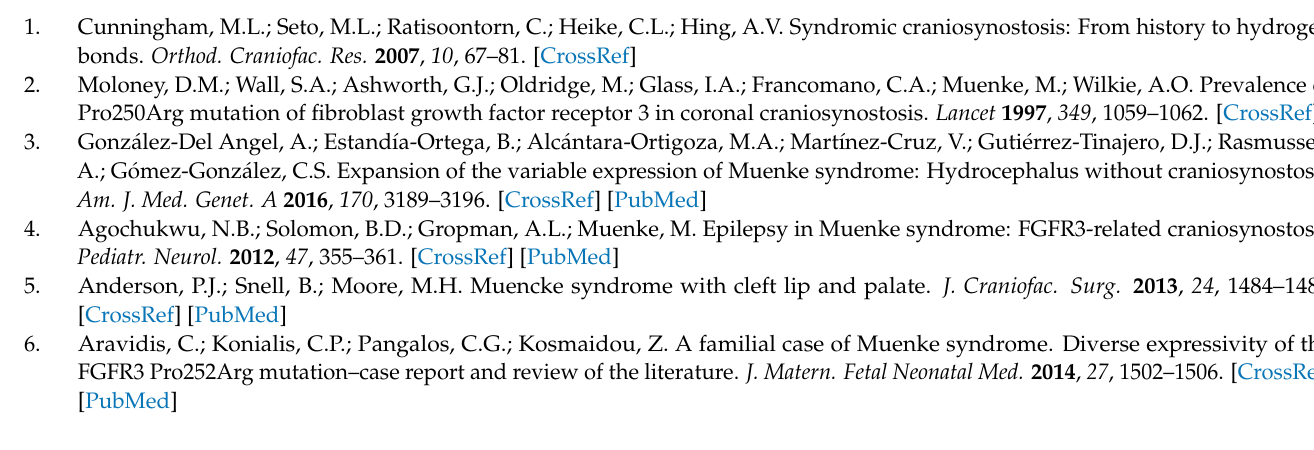
anatomical definitions. Supplementary Table S2: Showing the cephalometric analysis value of the proband, the proband’s mother and the proband’s father. Norm: Anglo-American. Supplementary Table S3: Mean values and number of standard deviations of the normal values for the general population of the angles SNA, SNB, and ANB. Supplementary Table S4: Primers and target for mutation sequencing. Supplementary Table S5: Antibodies used for